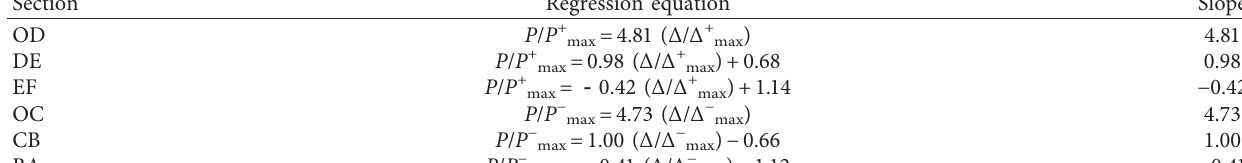
Table 3: The equation of the skeleton curve.